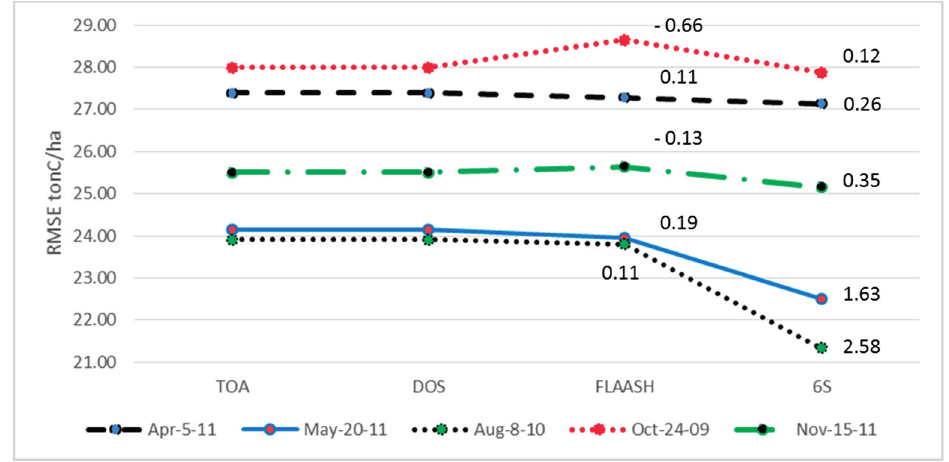
Figure 6. RMSE of AGB estimation with application of atmospheric correction methods at Gongju and Sejong region. The numbers in the graph are the RMSE differences between FLAASH and TOA and between 6S and TOA (the difference between DOS and TOA was